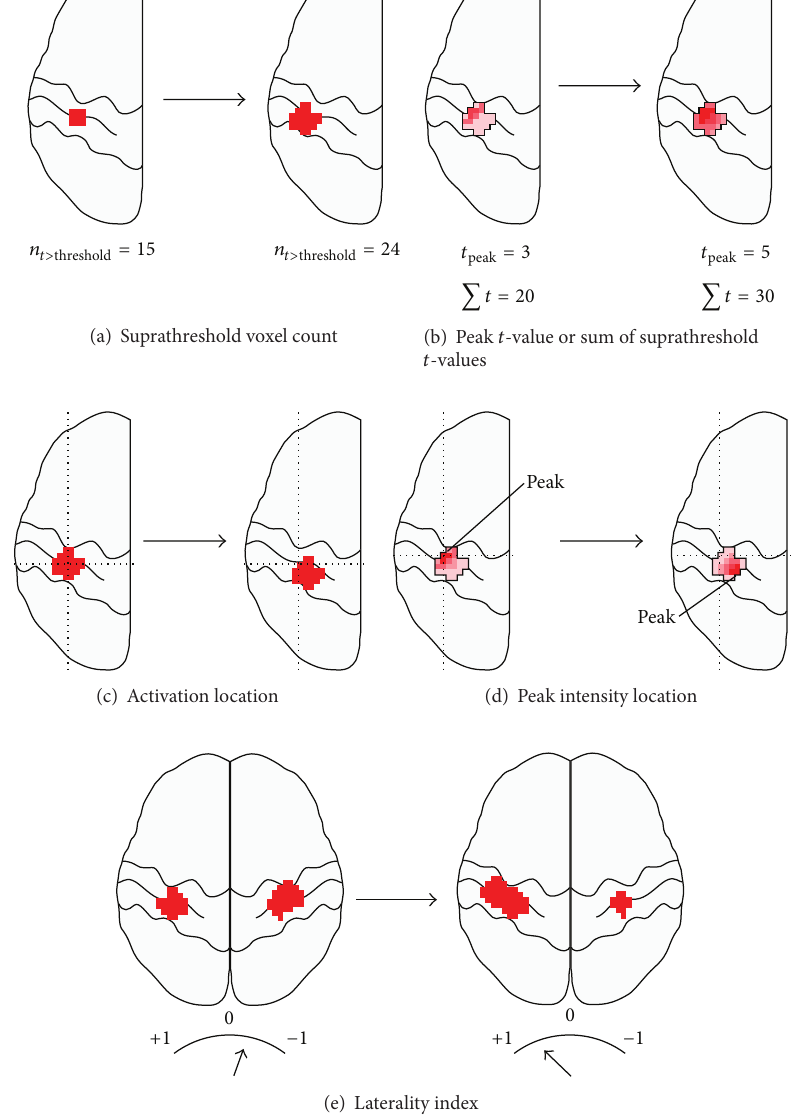
Figure 1: Commonly seen fMRI activation changes. Common fMRI activation pattern changes reported in the literature include suprathreshold voxel counts (a), peak 𝑡 -values or sum of suprathreshold 𝑡 -values (b), activation location (c), peak 𝑡 -value location (d), and changes in laterality index (e). Some studies report changes over time, while others report differences between groups. The degrees of changes shown here are for illustrative reasons